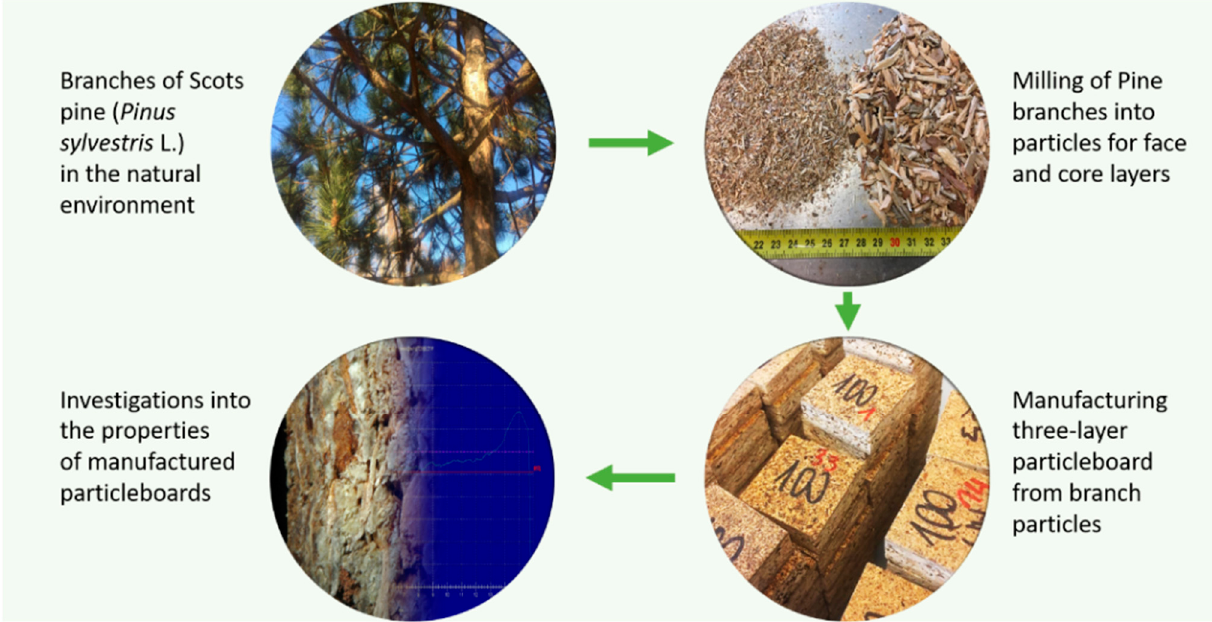
Figure 2. The general production process of three-layer particleboard from pine branches. Table 1. Compositions of elaborated particleboards.